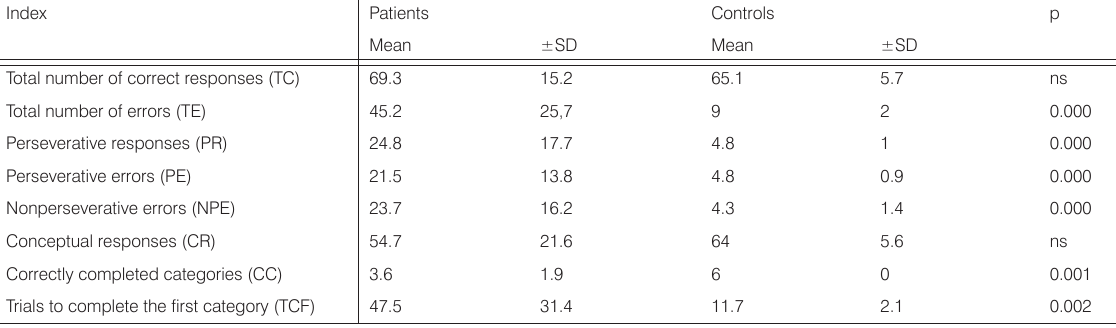
Table 2. Wisconsin Card Sorting Test scores in patients and healthy controls.